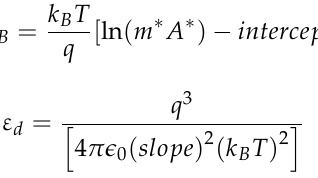
Figure 7. Pulse waveforms of the potentiation and depression process. During the depression process, the decrease in conductance is relatively linear com- pared with the potentiation process, which indicates the partial/gradual and nearly linear dissolution of CFs.